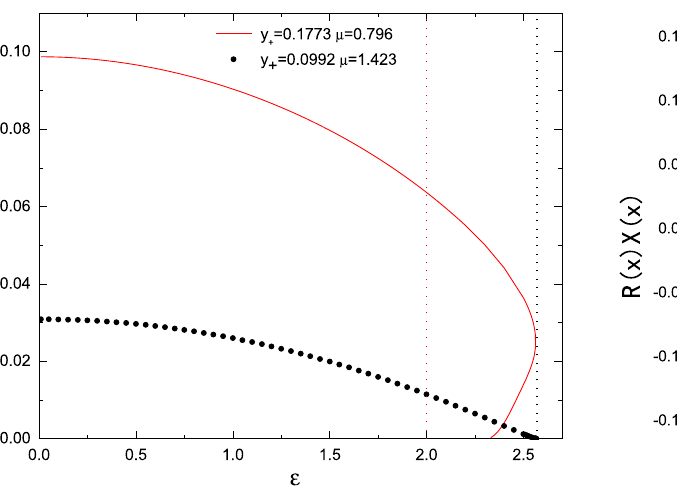
Fig. 11 The real part of frequencies ω against the rotation parameter ε of two small branches when choosing μ = 2 q equalto0 . 796and1 . 423for y + = 0 . 1773and y + = 1 . 423respectively. The red vertical line represents ε = 2